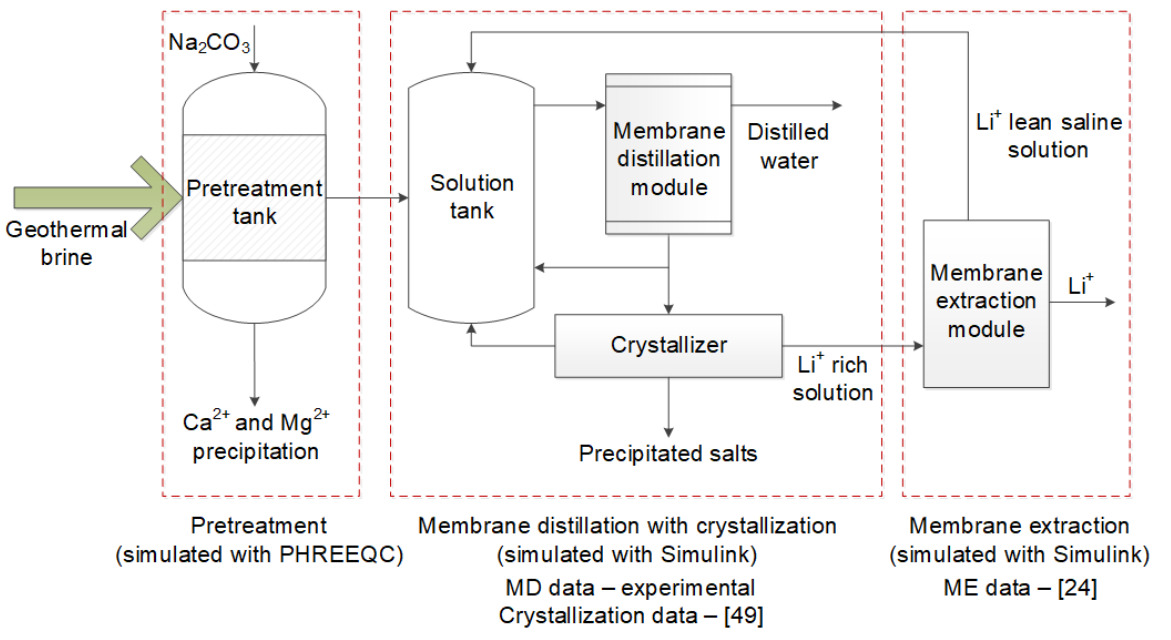
Figure 1. Principal scheme of three-stage process for lithium recovery from geothermal